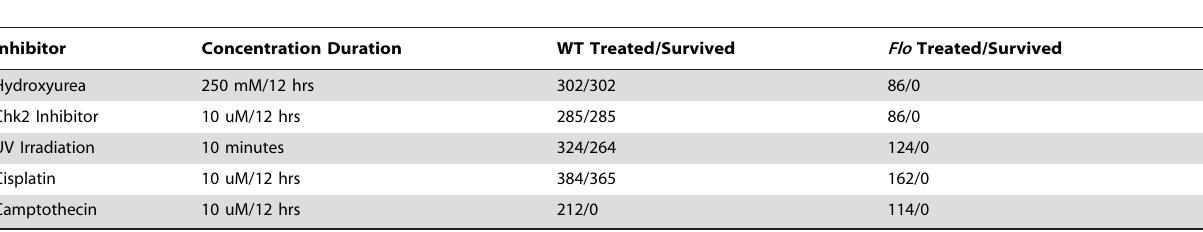
Table 1. Effect of DNA replication inhibitors on wt and flo